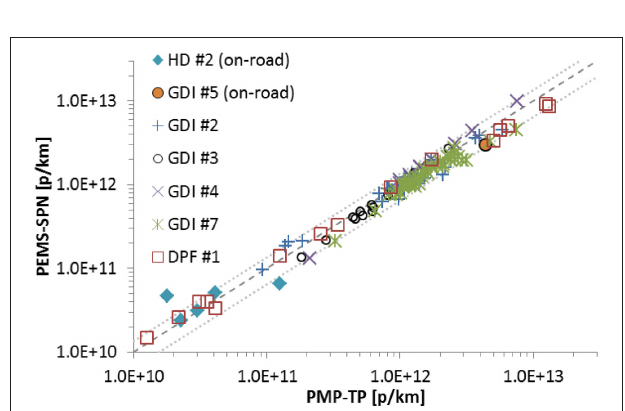
FIGURE 2 | Deviations between the SPN emissions measured at the tailpipe with the PEMS-SPN and the PMP-TP system; each point represents a phase of a test cycle. Tests are conducted in the laboratory, unless otherwise specified (on-road). The dotted lines represent deviations of − 35% (0.65:1) and + 35% (1.35:1) from the 1:1